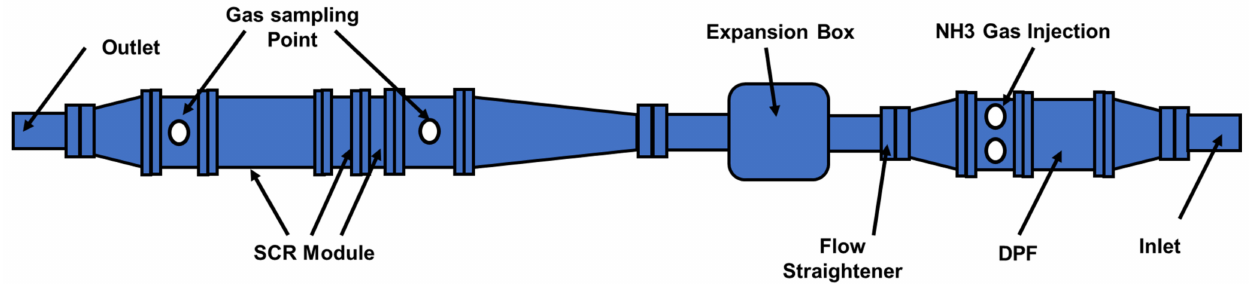
Figure 9. The exhaust system on a 2000 cc diesel engine test rig